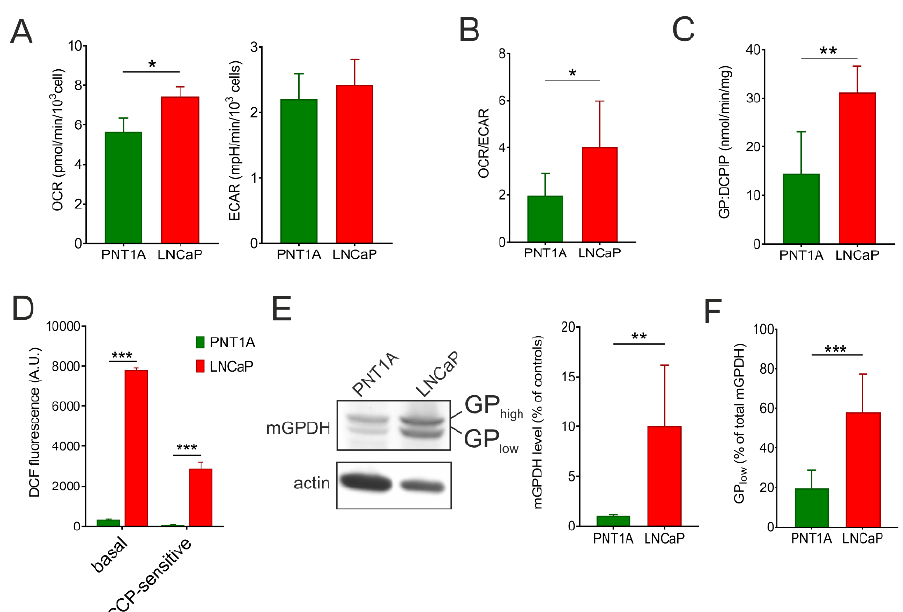
Figure 1. Energy metabolism and mGPDH content in prostate cancer cells. The oxygen consumption rate (OCR) and extracellular acidification rate (ECAR) ( A ), as well as OCR / ECAR ratio ( B ) in prostate cancer cells (LNCaP) compared to control epithelial cell line (PNT1A). Values were calculated from the rates in basal conditions, i.e. at the presence of 10 mM glucose, and determined by a Seahorse XFe analyzer ( n = 5). ( C ) Enzyme activity of mGPDH measured spectrophotometrically using 10 mM glycerol-3-phosphate as a substrate ( n = 6). ( D ) ROS generation in intact LNCaP cells compared to control PNT1A measured by the CM-H 2 DCFDA probe. To determine the FCCP-sensitive portion of ROS production, 1 µ M uncoupler was used. ( E ) Cell lysates (15 µ g protein) were separated on SDS-PAGE and mGPDH content was analyzed by Western blotting using a specific antibody against mGPDH, actin was used as a loading control. Representative blot of 5 independent experiments is depicted. Antibody signals were quantified densitometrically as the total mGPDH levels normalized to actin levels and the results are expressed as % of control values. ( F ) Processing of mGPDH was determined densitometrically as a ratio of the lower band and total mGPDH content ( n = 5). Data represent the means ± S.D., * p < 0.05, ** p < 0.01, *** p <